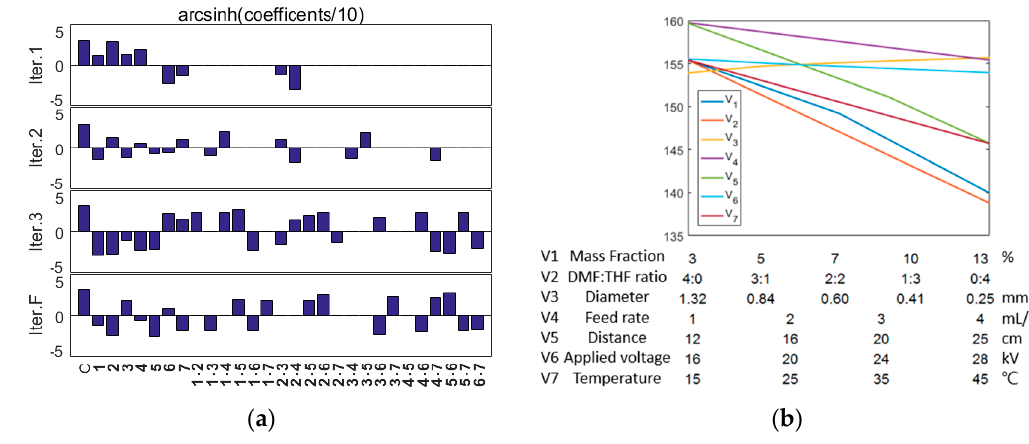
Figure 3. Coefficients of every term in the regression models corresponding to Figure 1c. ( a ) From left to right, C and bold numbers are separately representing the constant term, linear terms (1~7: mass fraction, mass ratio of N-Dimethylformamide (DMF) and Tetrahydrofuran (THF), inner diameter of needle, feed rate, receiving distance, applied voltage and temperature), and interaction terms. The y coordinates are transformed by a non-linear function arcsinh (x/10). ( b ) Each line represents the variation of contact angle caused by change of each single condition predicated by model of Iter.F in the optimal combination identified, and the labels V1 to V7 at the bottom give the values of the different x-axes for the data plotted on the y-axis as V1 to V7.